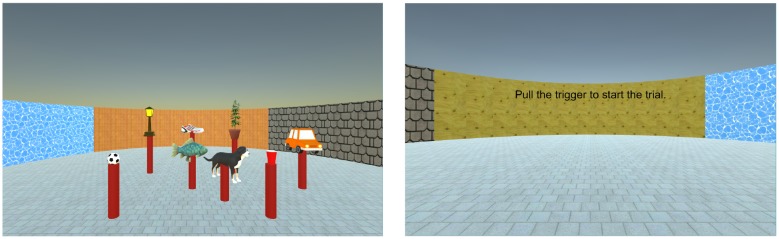
Left. Participants’ actual view in the learning phase in Experiment 2. Right. Participants’ initial view (M condition) in the testing phase in Experiment 2. The walls would disappear when participants pulled the trigger to start the trial.